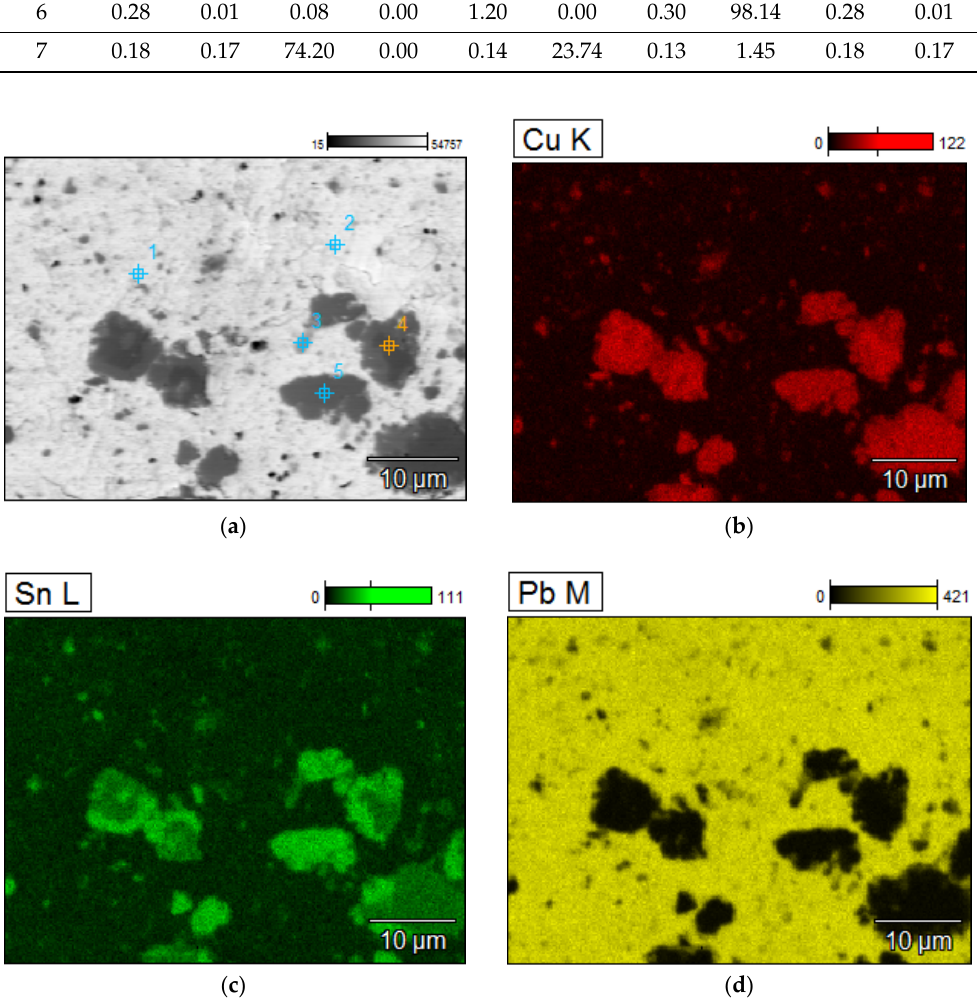
Figure 9. Elements mapping of the lead ingots after melting with PCB pyrolyzate “server”, m PCB / m Pb = 0.1 g · g − 1 . ( a ) scanning electron microscopy with a points of chemical composition; ( b – d ) copper, tin and lead located in specific areas within the alloy. Table 11. Point chemical compositions of the lead ingots after melting with PCB pyrolyzate “serv- er”, m PBC / m Pb = 0.1 g ∙ g − 1 , points of analysis from Figure 9 .